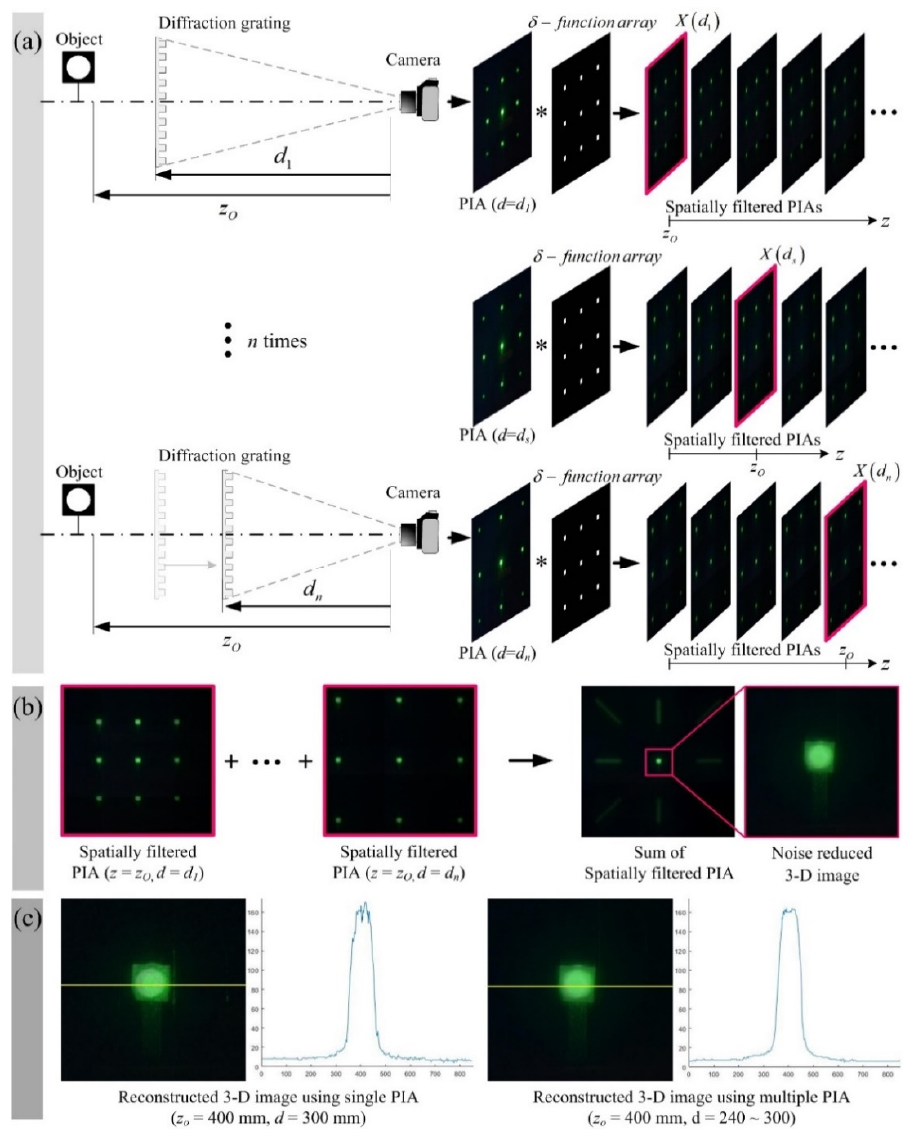
Figure 4. 3-D image reconstruction process with multiple PIAs. ( a ) PIA acquisition process and spatial filtering process. The distance d between the diffraction grating and the camera is sequentially changed to acquire PIAs. Spatial filtering is performed on each PIA to extract PIAs corresponding to successive depths. ( b ) After adding spatially filtered PIAs corresponding to the same depth, z O , the proposed 3-D image is reconstructed. ( c ) Comparison of 3-D reconstructed images in intensity profile.